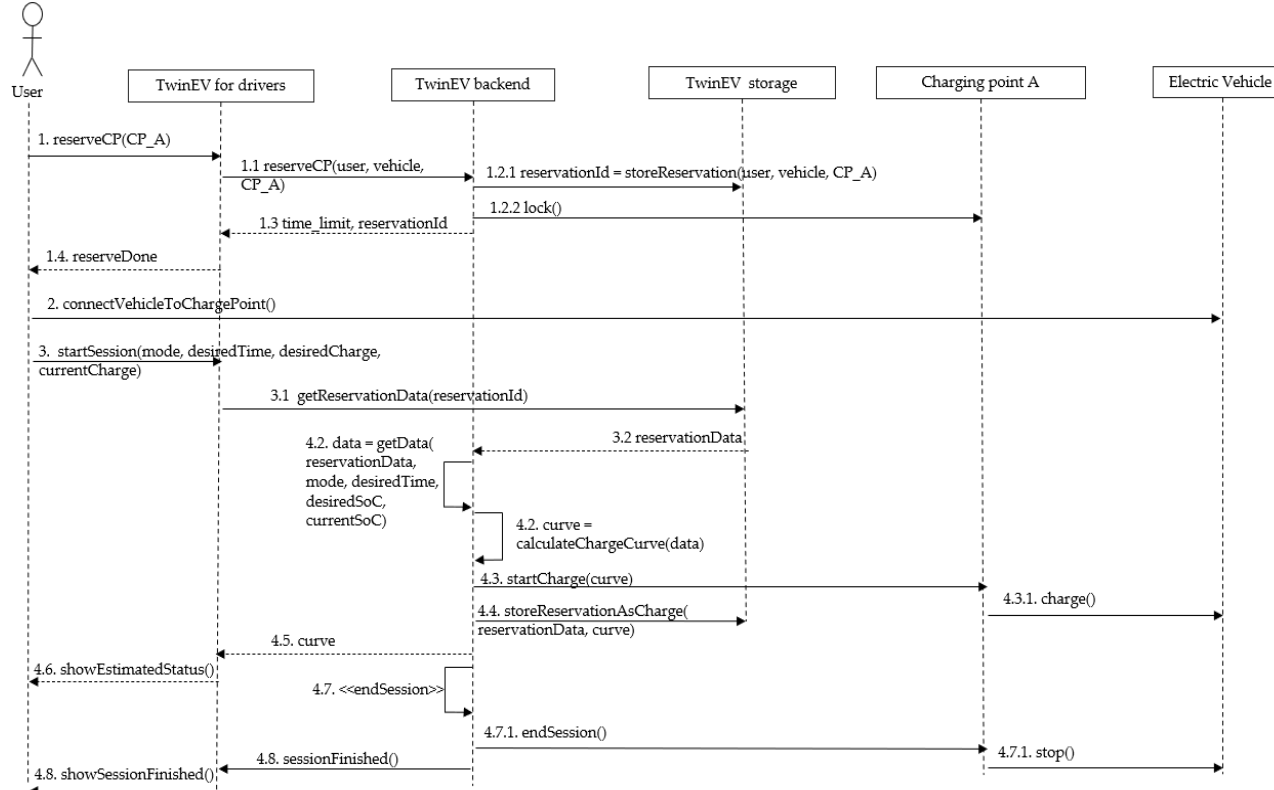
Figure 3. Actions flow of booking a charge session.